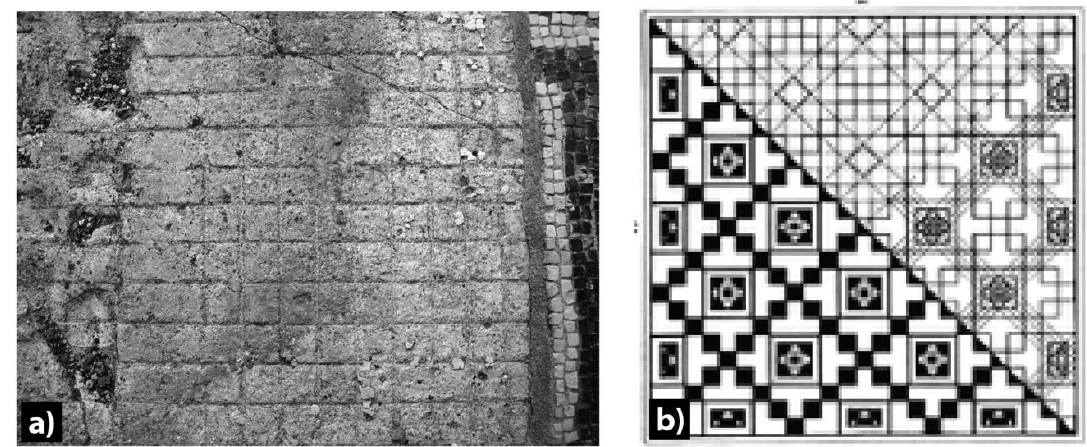
Figure 3. ( a ) View of the sinopia of a mosaic belonging to the domus of [21], from Pompeii. ( b ) Scheme of mosaic construction based on the sinopia, from